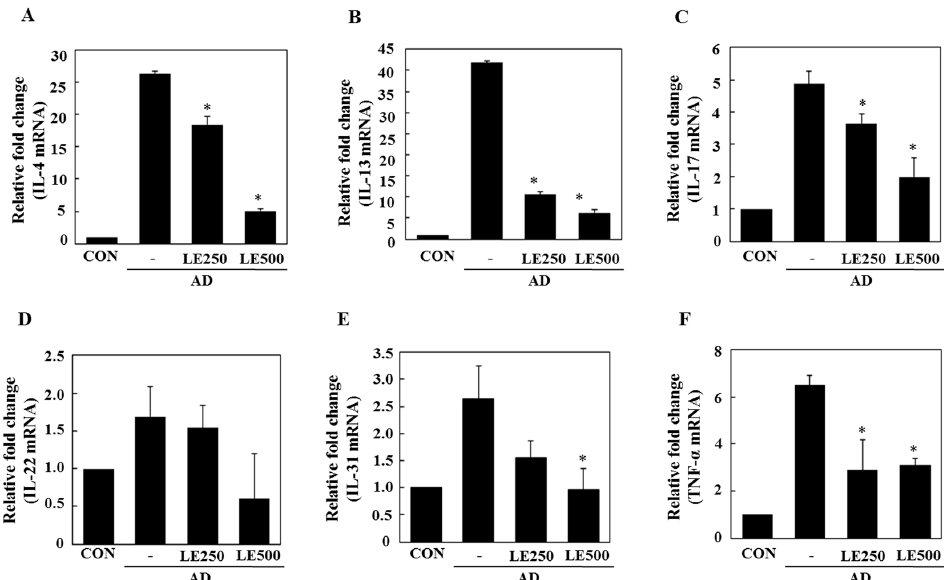
Figure 4. Effect of L. edodes extract on the expression of various cytokines in the ear. The ears were excised on day 28 and total RNA was isolated. Quantitative real-time polymerase chain reaction was performed as described in the Materials and Methods. The relative fold change in mRNA for IL-4 ( A ); IL-13 ( B ); IL-17 ( C ); IL-22 ( D ); IL-31 ( E ); and TNF α ( F ) are shown. Data are presented as the mean ± SD of triplicate determinations. * Significantly different from the value of the DFE/DNCB-treated mice at p < 0.05. DFE, Dermatophagoides farinae extract; DNCB, 2,4-dinitrochlorobenzene; AD, atopic dermatitis induced by DFE and DNCB treatment.